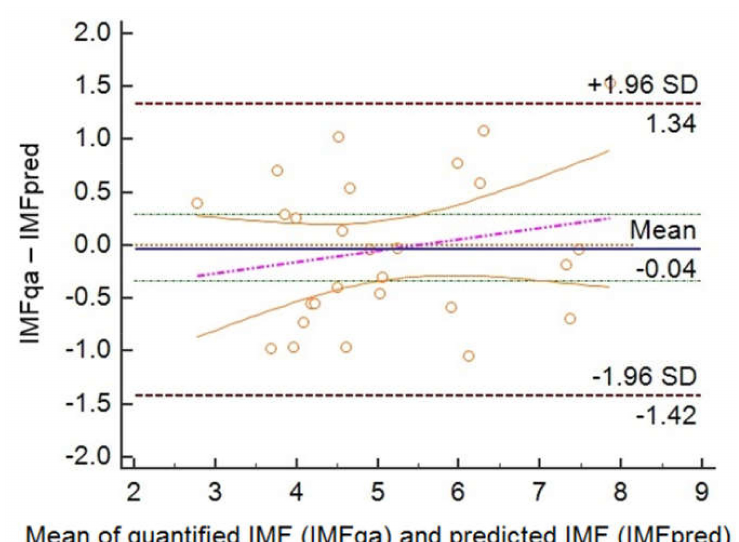
Figure 4. Bland-Altman plot of quantified IMF (IMFqa) versus predicted IMF